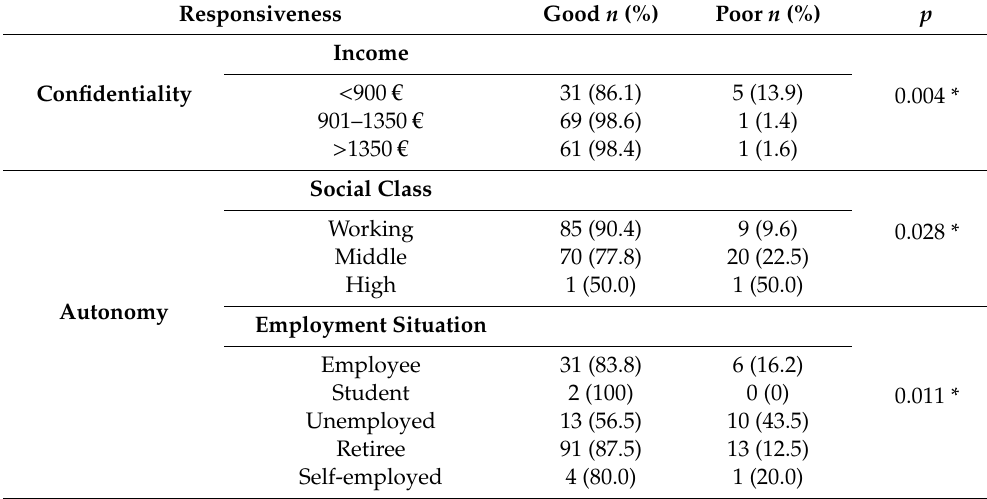
Table 4. Association between responsiveness and patients’ economic income, social class, and employment